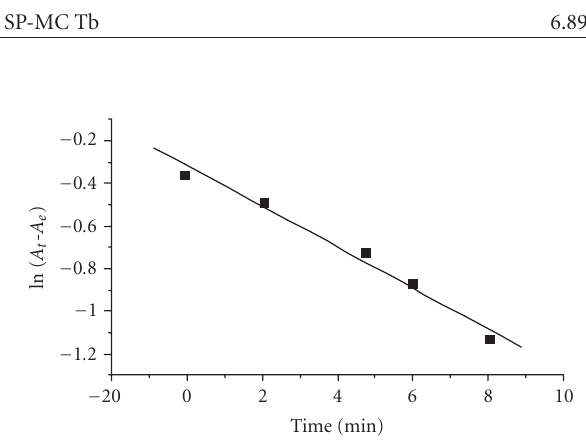
the presence of 3 × 10 − 5 M of SP in (1) DMSO and (2) acetonitrile. λ = ex